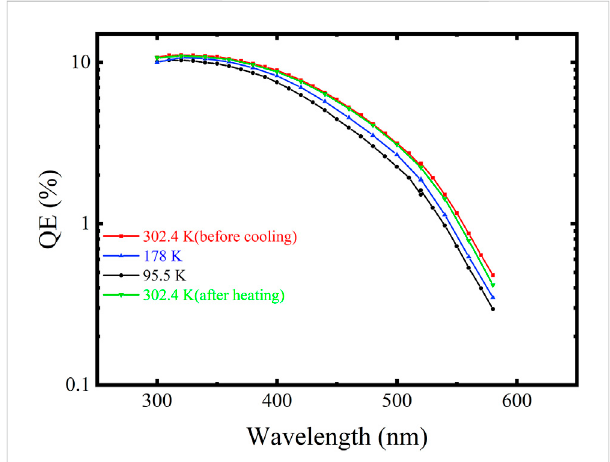
FIGURE 1 Spectral responses of the K-Cs-Sb photocathode at 302.4, 178, and 95.5 K during a cooling-warming